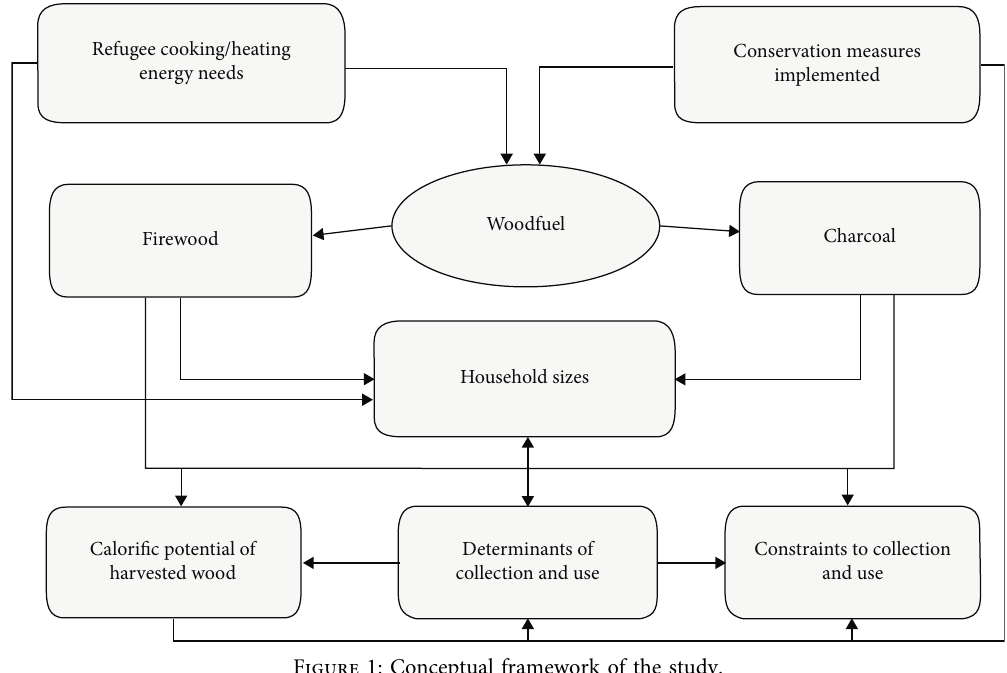
Figure 1: Conceptual framework of the study.